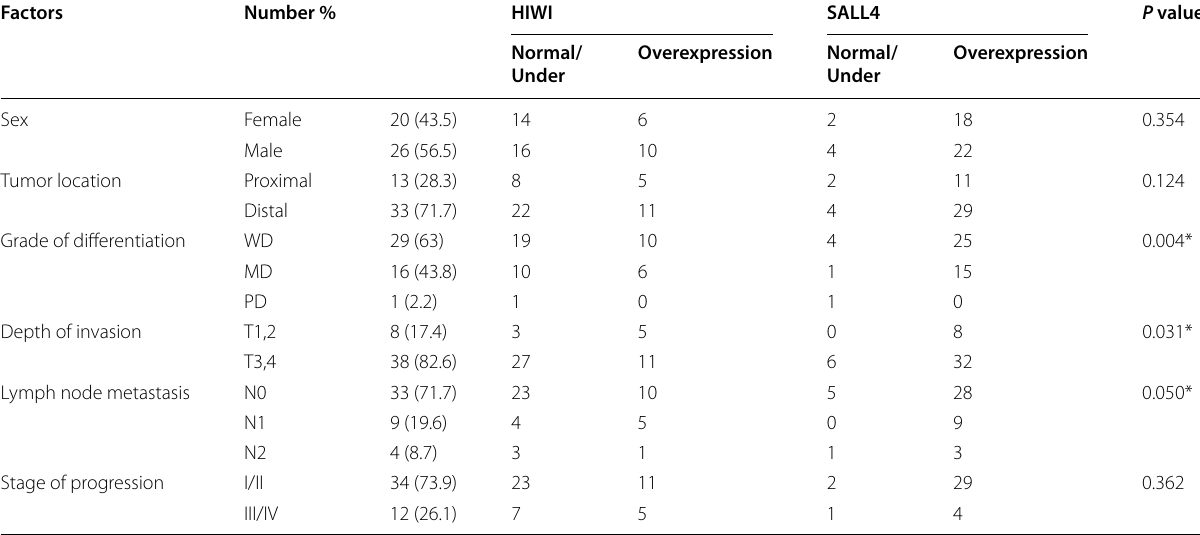
Table 2 Correlation of SALL4 and HIWI genes expression with clinicopathological features of the patients